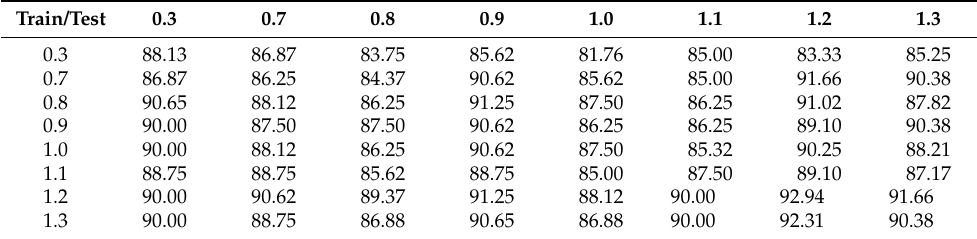
Table 6. Accuracy obtained by LM 68 with different resizing factors (reported in percentage).